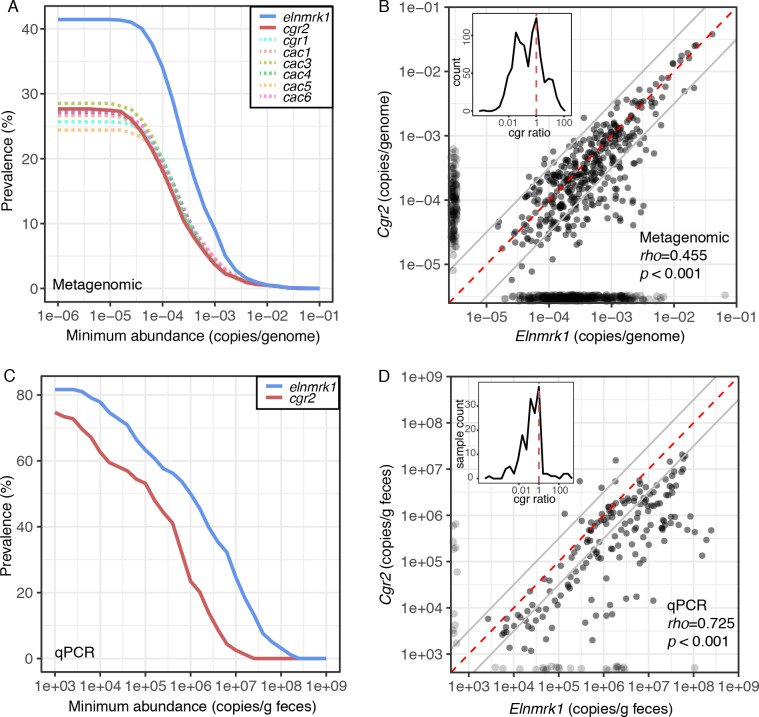
Cgr2 is widespread in the human gut microbiome.(A) Analysis of the cgr-associated gene cluster and E. lenta (via elenmrk1) prevalence in the gut metagenomes of 1872 individuals (see Materials and methods) revealed that both E. lenta and cgr2 are highly prevalent (41.5% and 27.7% respectively) but frequently low in abundance. (B) Quantification of E. lenta and cgr2 abundances in individual gut metagenomes revealed a tight correlation between the two, providing evidence that cgr2 is restricted to E. lenta and that individuals may harbor sub-populations of both cgr2+ and cgr2- strains. Red line denotes the expected linear relationship and dashed lines represent a ± half log deviation. (Inset) Histogram of cgr-ratio (cgr/elnmrk1) demonstrates a significant skew away from communities that would have more cgr2 than expected by E. lenta abundance (p<0.001, D’Agostino skewness test). (C) Replication in an additional 158 individuals located in the USA (n = 85) and Germany (n = 73) via duplexed qPCR increased prevalence estimates to 74.7% and 81.6% at the extremes of detection limit (1e3 copies/g). qPCR samples were run in technical triplicate (Figure 6—source datas 1 and 2). (D) Similarly, qPCR-derived abundances of E. lenta and cgr2 were correlated, corroborating metagenome-based analysis. (Inset) Histogram of cgr-ratio demonstrating significant skew (p<0.001).10.7554/eLife.33953.033Figure 6—source data 1.qPCR based E. lenta and cgr2 prevalence.Prevalence based on median of abundance in individuals with repeated sampling.10.7554/eLife.33953.034Figure 6—source data 2.Replicate qPCR data of for cgr2 and elnmrk1 in human fecal samples.